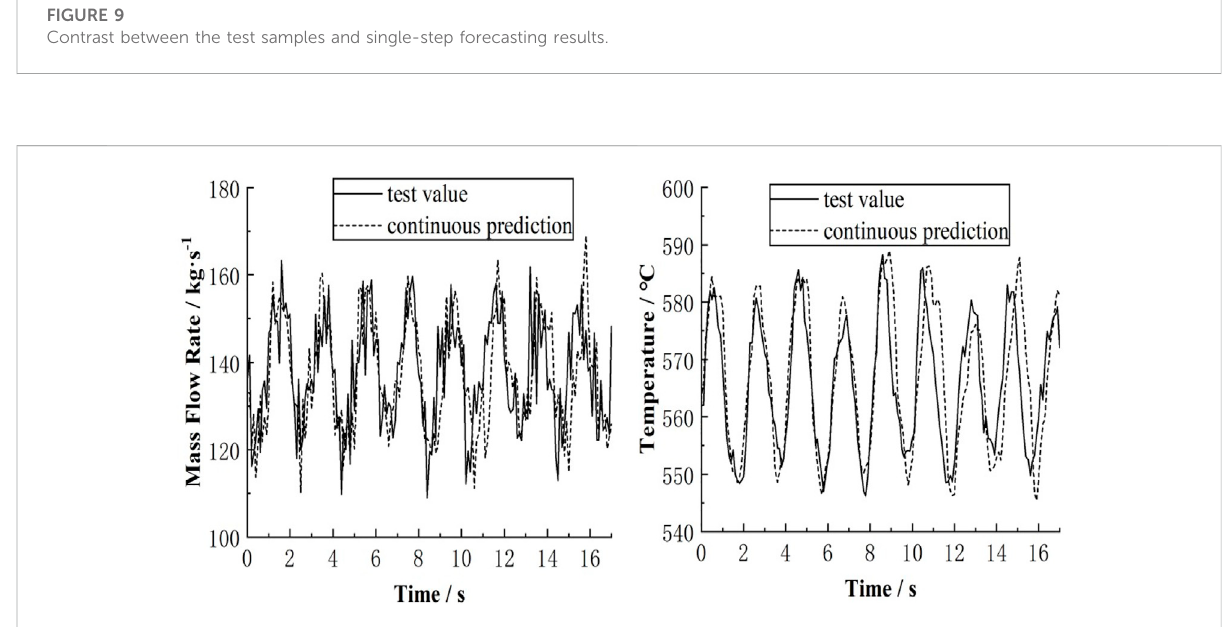
FIGURE 10 Contrast between the test samples and continuous forecasting